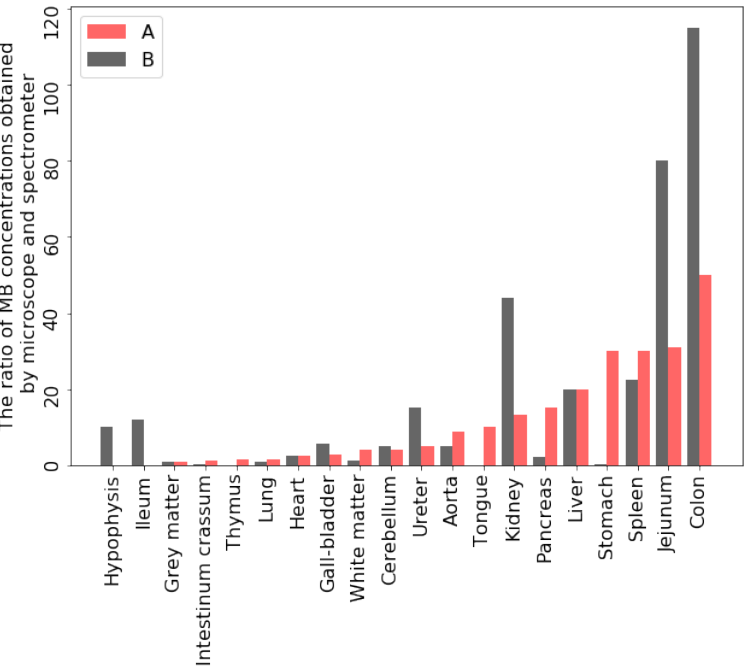
Figure 13. The ratio of MB concentrations in different organs obtained by laser scanning confocal micro- scope and spectrometer: Primate A, 3 h after MB administration; Primate B, 24 h after MB